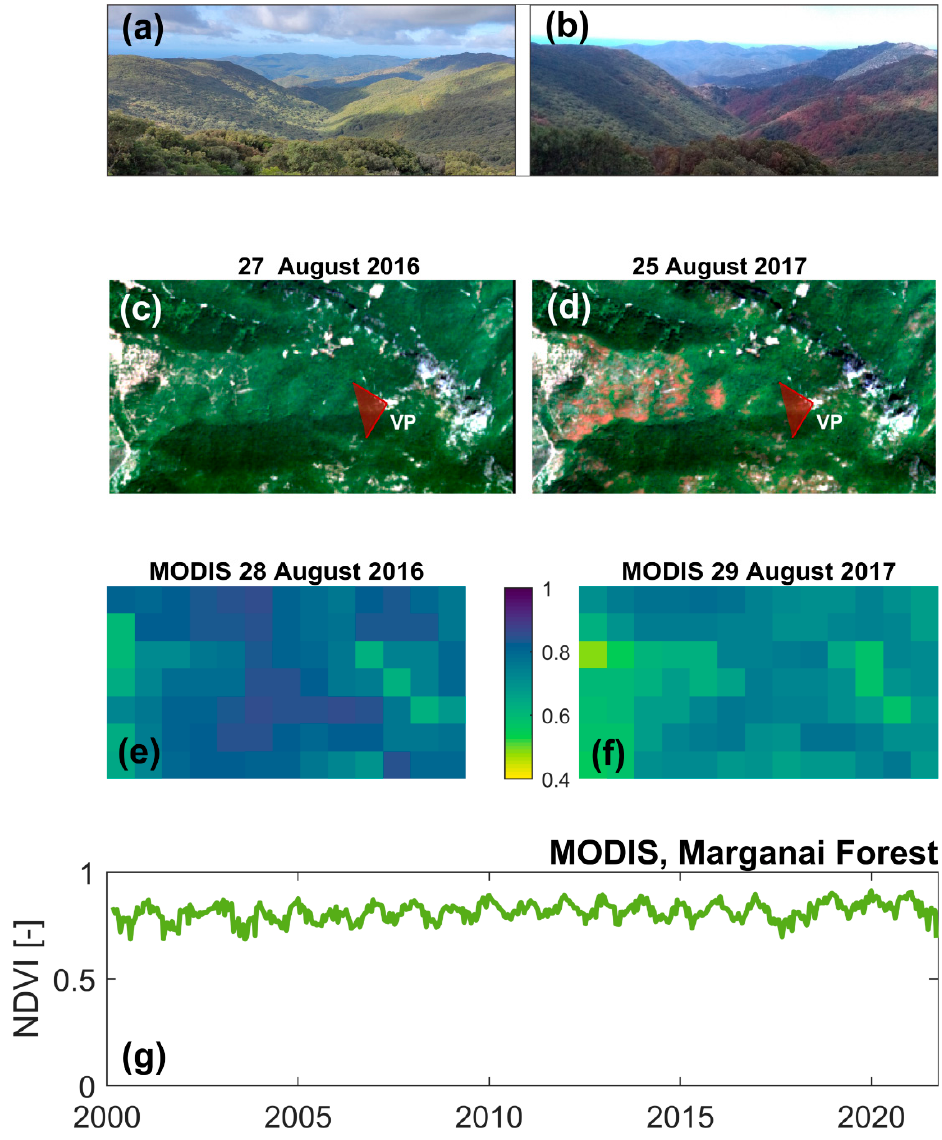
Figure 1. Comparison of the state of the Marganai forest in summer 2017 with that in the previous summer: ( a , b ) pictures of the forest from the VP sight point shown in panels ( c , d ) in summer 2016 and summer 2017, respectively; ( c , d ) images of Sentinel 2 satellite at 10 m spatial resolution (VP is the view point of the pictures in ( a , b )); ( e , f ) NDVI maps from MODIS images at 250 m spatial resolution; ( g ) time series of the forest average NDVI (~16 − day temporal resolution) from MODIS data.